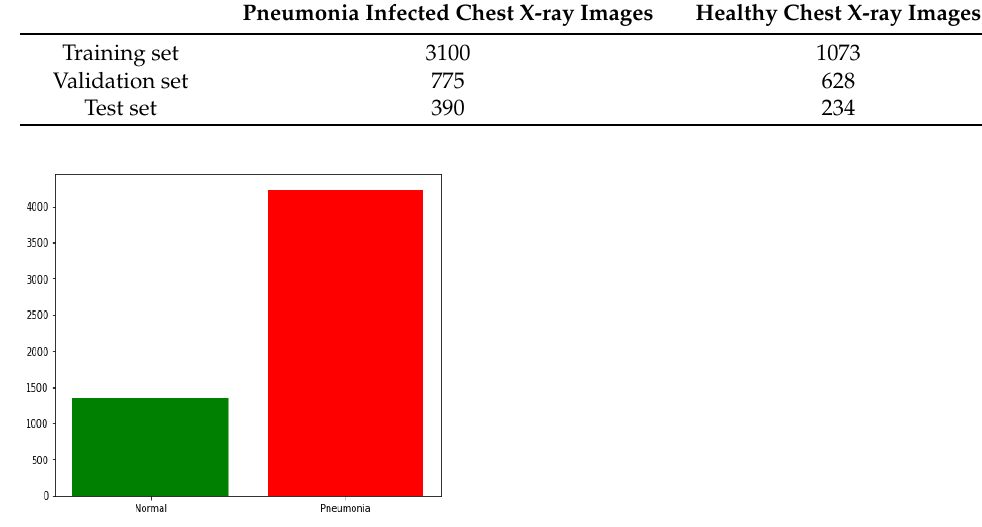
Figure 6. The training set distribution of image classes showing the disparity in data used for